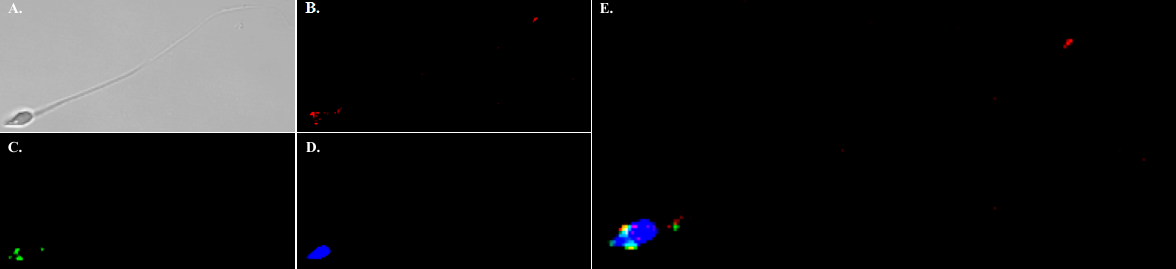
Figure 7. Immunolocalization of NHE11 in mature human sperm. Immunolocalization of NHE11 in mature human sperm was performed with our anti-NHE11 antibody. ( A ) DIC image of the human sperm cell. ( B ) Anti-NHE11 immunofluorescence (red). ( C ) PNA-FITC staining of the acrosome (green). ( D ) DAPI staining of cell nucleus (blue). Note that NHE11 staining is only observed in the sperm head. ( E ) Merged image of the three color channels ( B – D ). There may be some colocalization of NHE11 to the acrosomal region (yellow). Note that no NHE11 staining is observed in the sperm flagellum, similar to what is seen in the rat sperm cells. Images were taken on a Zeiss LSM 710 confocal microscope with a 63× objective.